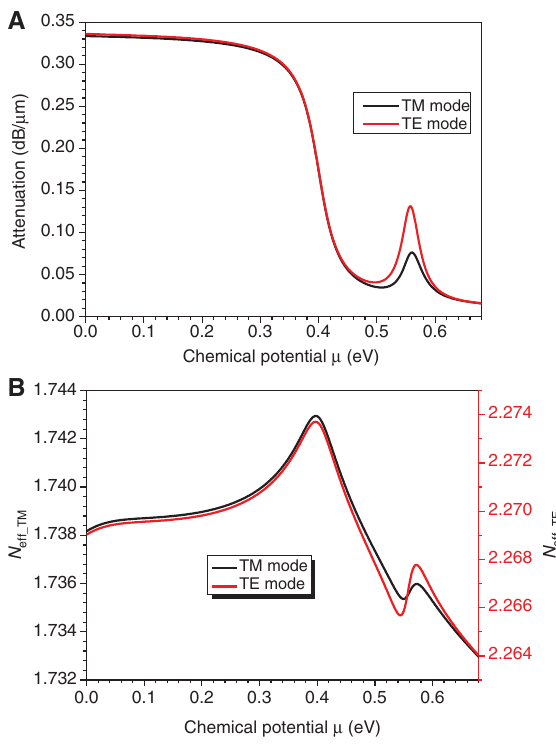
Figure 4: The change of the complex dielectric constant of graphene affects the mode property. (A) Attenuation and (B) mode effective index ( N as a function of chemical potential at λ = 1551.7 nm for two sup- ported TM and TE polarized